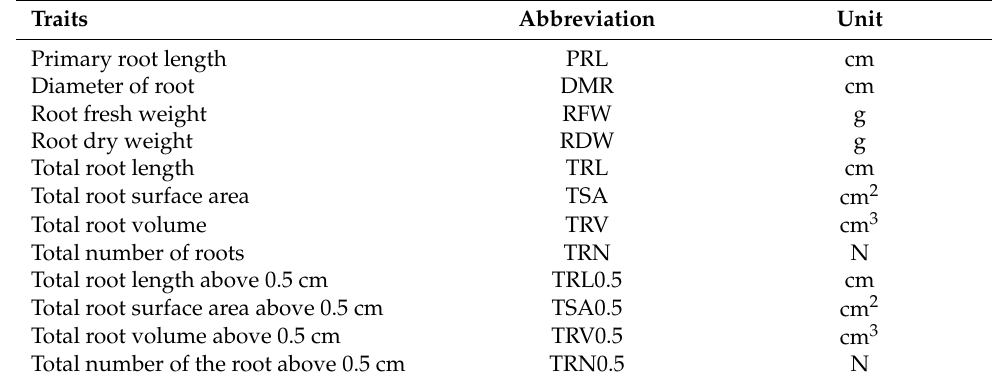
Table 1. Summary of the 12 evaluated root-related traits and their descriptions.